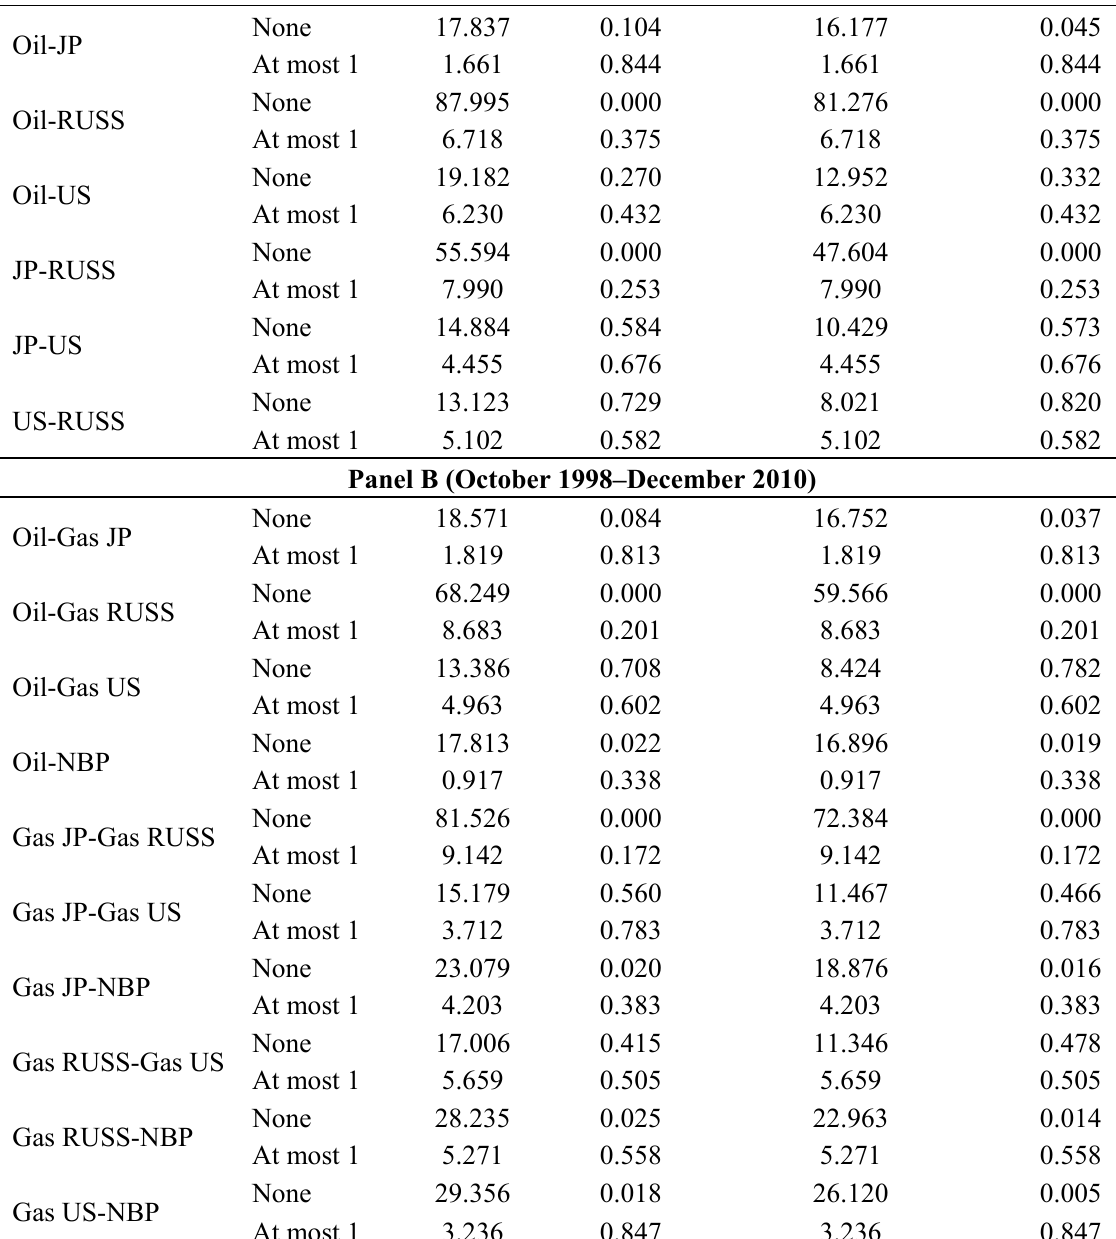
Table 2. Pairwise Johansen cointegration